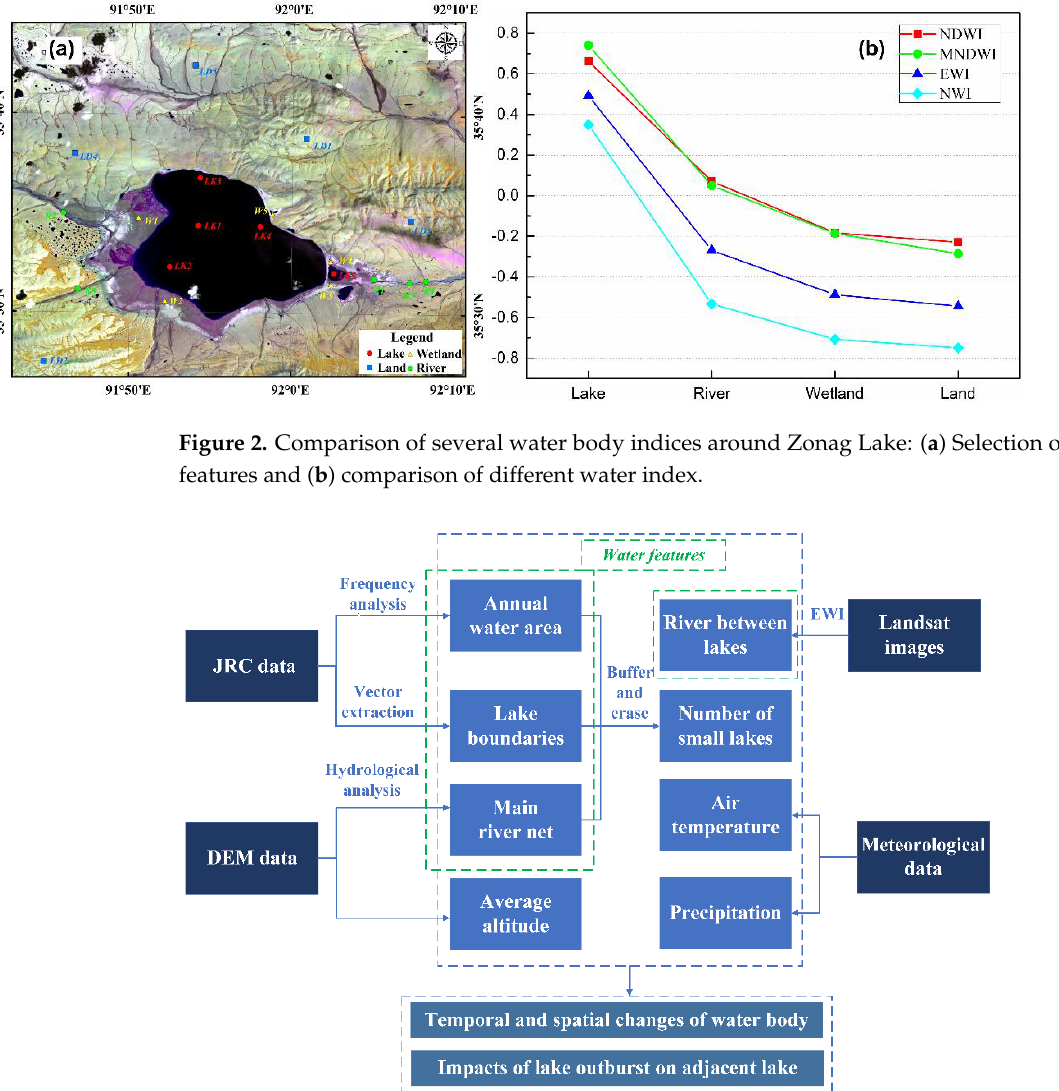
Figure 2. Comparison of several water body indices around Zonag Lake: ( a ) Selection of different features and ( b ) comparison of different water index.